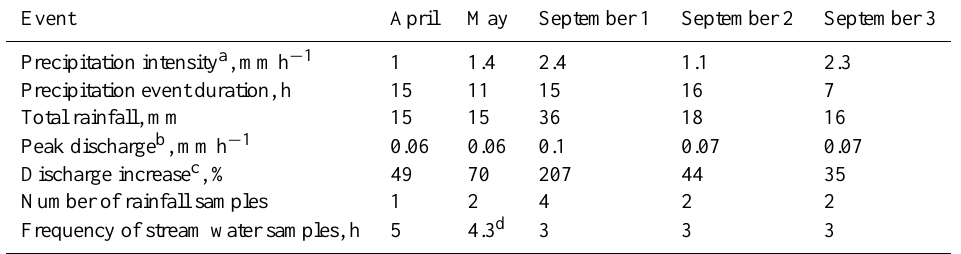
Table 4. Summary of rainfall and runoff characteristics with rainfall intensity and duration, peak discharge, maximum discharge increase and number of rain samples for each precipitation event. September is divided into three sub-events.